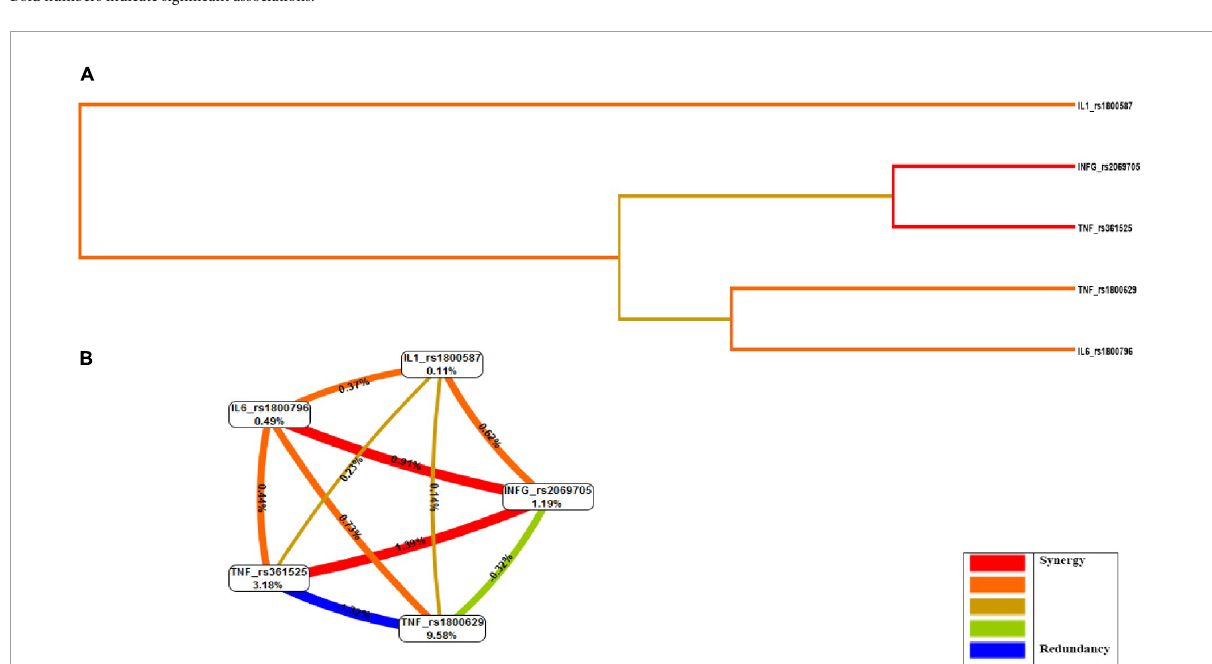
FIGURE1 Evaluation of gene–gene interactions: multifactorial dimensionality reduction analysis (MDR). (A) Dendrogram, (B) Fruchterman-Rheingold graph. MDR combined attribute network was calculated. The interaction I (A; C) is represented as a percentage (%) between the five vertices. This graphical model explains the percent of the entropy in case-control removed by each factor (independent effect) and by each pair-wise combination of attributes (interaction effect). A positive percentage of entropy indicates synergistic interaction and negative values of entropy represent redundancy. The red color indicates a high degree of synergistic interaction, orange indicates a lesser degree, whereas gold represents the midpoint; blue represents the highest level of redundancy, followed by